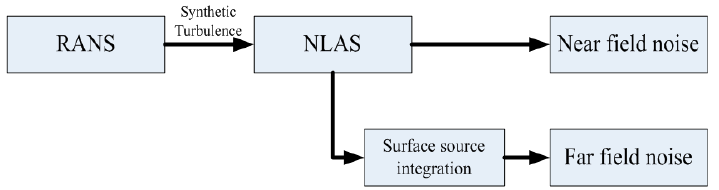
Figure 1. The schematic drawing of solution procedure for Computational aero ‐ acoustics (CAA)